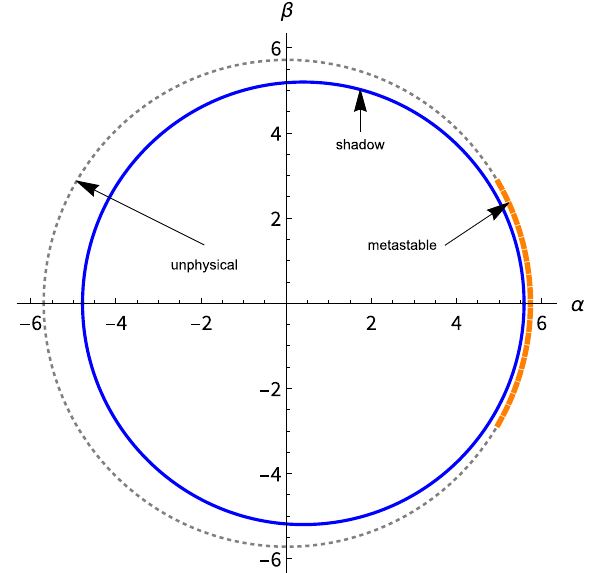
Fig. 2 The black hole shadow is surrounded by an incomplete section of Einstein rings. We adopt the same convention for the line types and colors as Fig. 1. Left: No Maxwell construction can be established for this case. Right: The resultant black hole shadow edge is shown by the